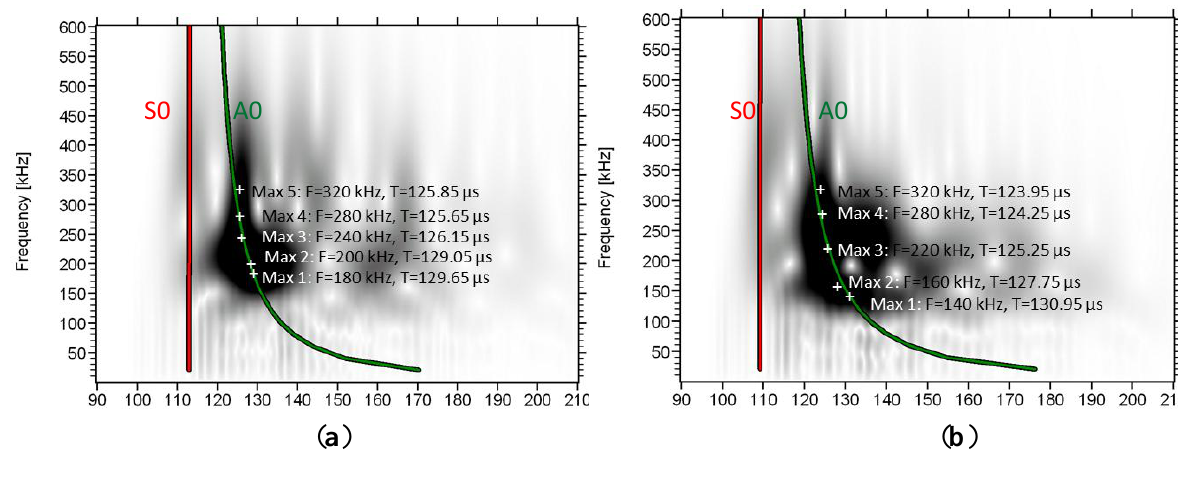
Figure 8. wavelet transformation for the 4th sensor for specimens with average cortical thickness ( a ) 5.45 mm and, ( b ) 6.65